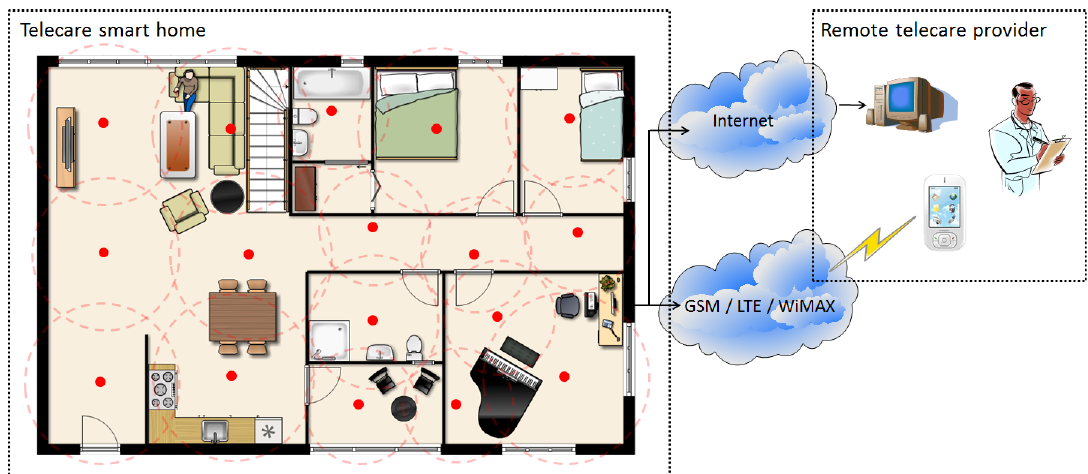
Figure 1. Scenario of ZigBee-based location-aware fall detection